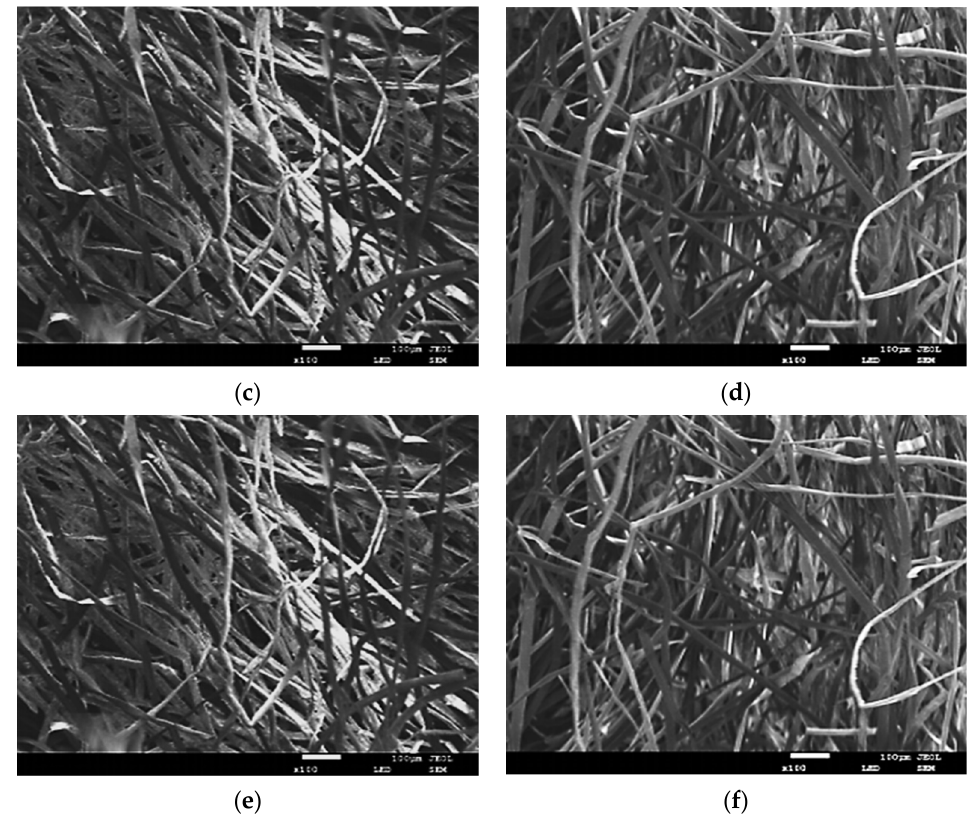
Figure 7. SEM images of composite materials with different thicknesses. ( a ) 11# (0.5 cm); ( b ) 12# (1 cm); ( c ) 13# (1.5 cm); ( d ) 14# (2 cm); ( e ) 15# (2.5 cm); ( f ) 16# (3.0